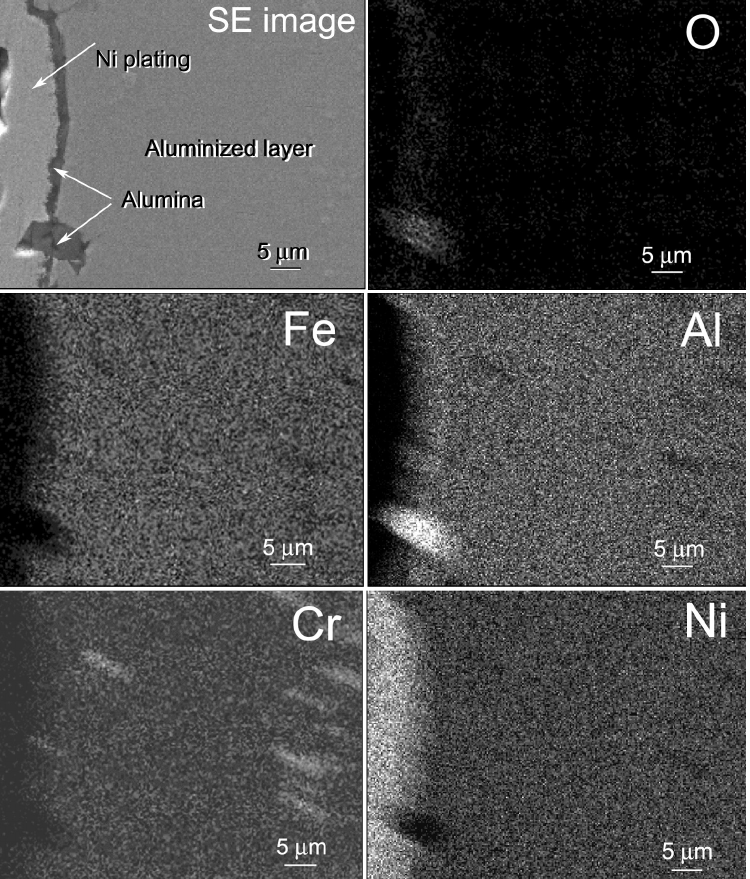
Figure 3. Cross-section EDS maps of O, Al, Fe, Cr, and Ni elements in alumina layer formed on aluminized Fe-Cr-Ni alloy after oxidation in H 2 C 2:23 vol. % water vapor at 1273 K for 30